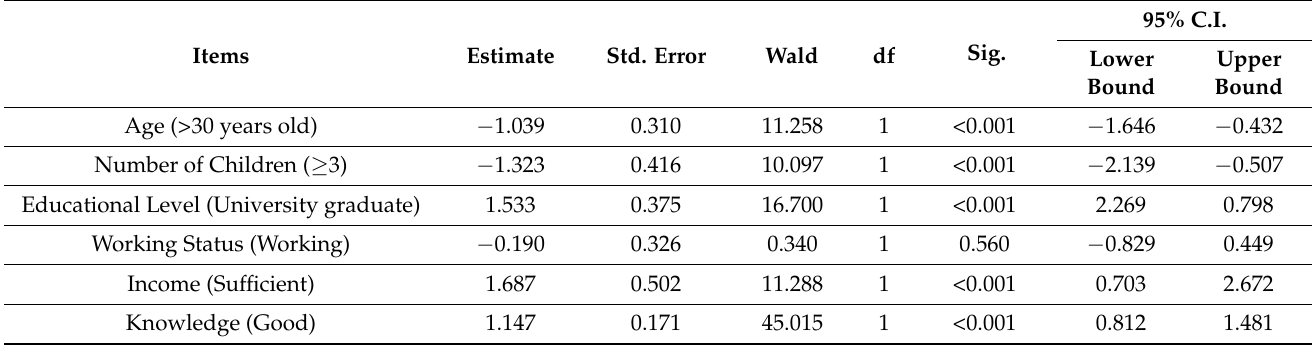
Table 3. Ordinal logistic regression analysis of predictor variables on mothers’ management practices of